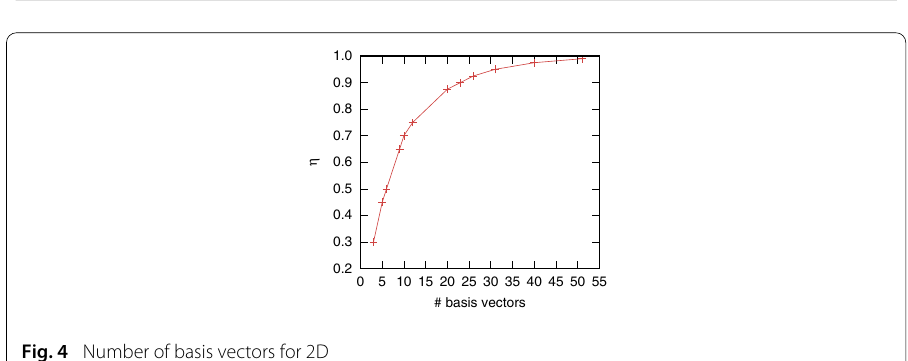
Fig. 3 Hyper-ROM temperature contours at t = 1, t = 2, and t = 3 s for the 2D differentially heated cavity